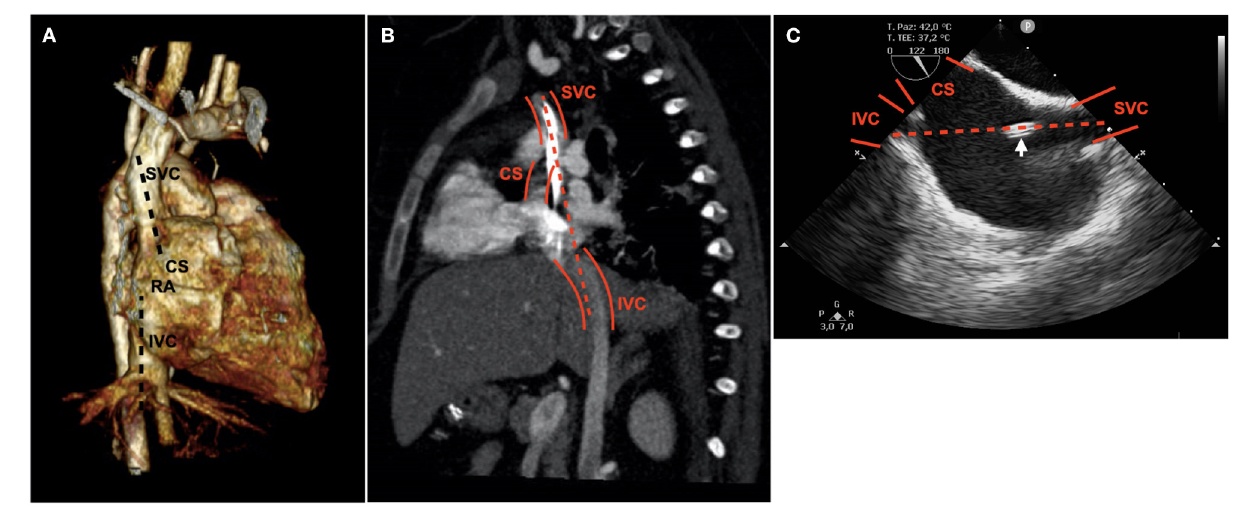
FIGURE 2 | Relative position of the SVC and IVC. The IVC is more posterior and laterally displaced with respect to the SVC. RA, right atrium. The main axis of the SVC is directed toward the opening of the CS (A,B) . Mid-esophageal bicaval view; the CS appears misleadingly bigger than the IVC; the arrow indicates the advancing dilator. The dashed line shows the trajectory of the guidewire (B,C)